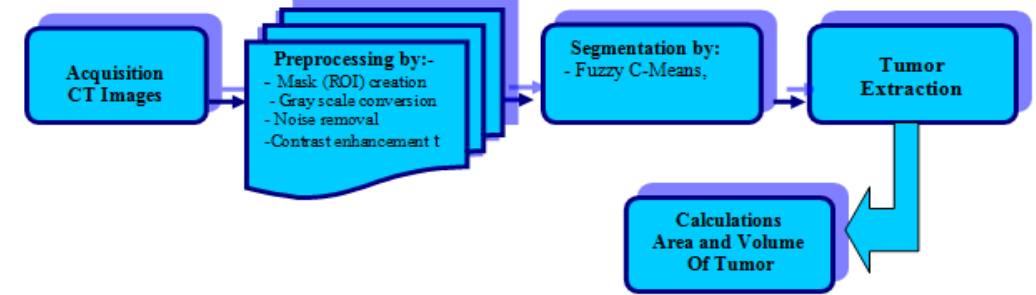
Fig.1: The block diagram of the basic